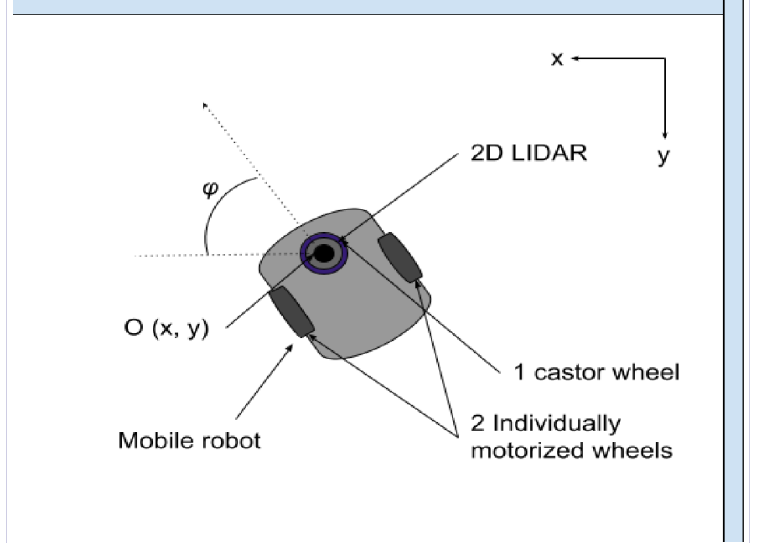
Figure 2. A simplified scheme of a differential drive mobile